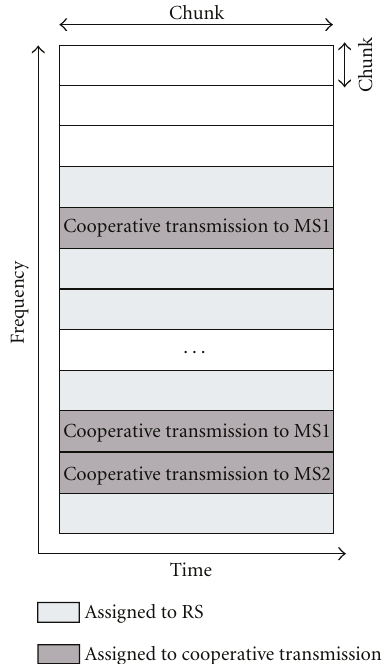
Figure 6: Scheduling restrictions at the RS. The RS receives resource allocation for cooperative transmissions from the BS. Together with the flexible resource assignment this restricts the resources the RS can use to schedule noncooperative